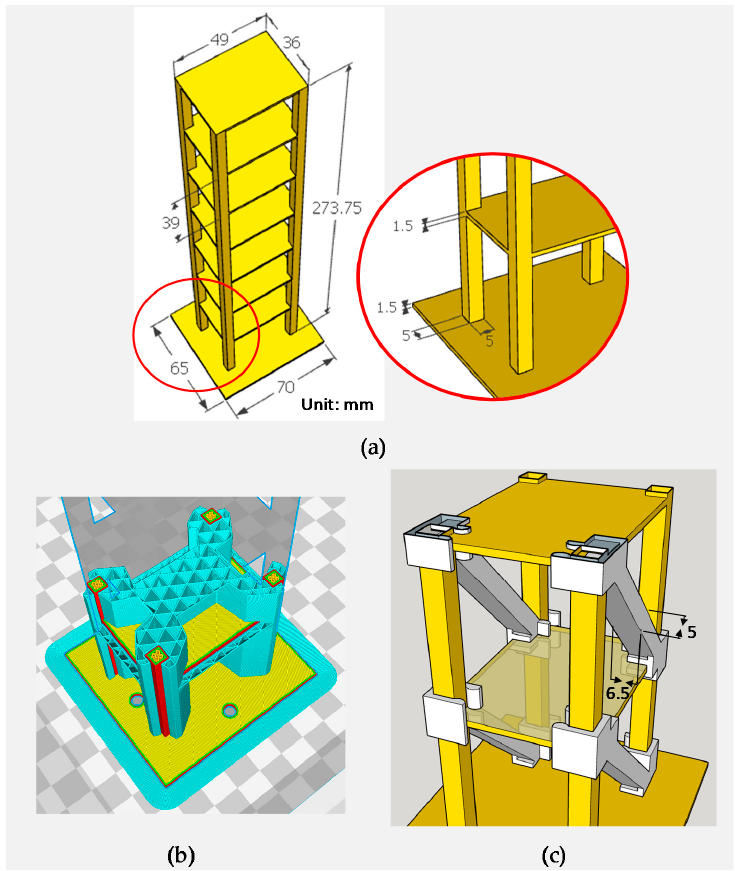
Figure 1. Dimension of the specimen and bracing systems. ( a ) 3D-printed seven-story specimen; ( b ) Design of the supporting material and slicing results; ( c ) Installation of the bracing systems.